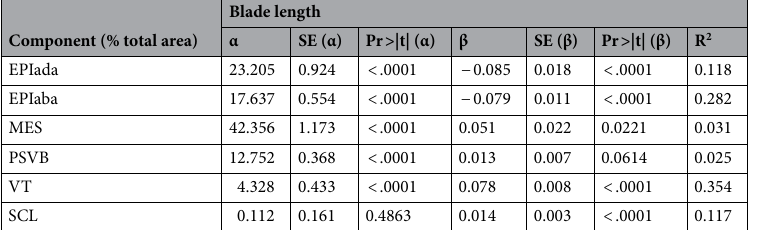
Component (% total